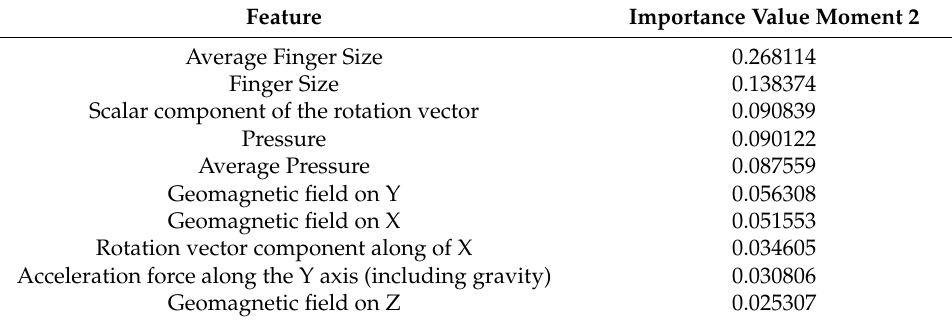
Table 8. Top 10 ranking features for Moment